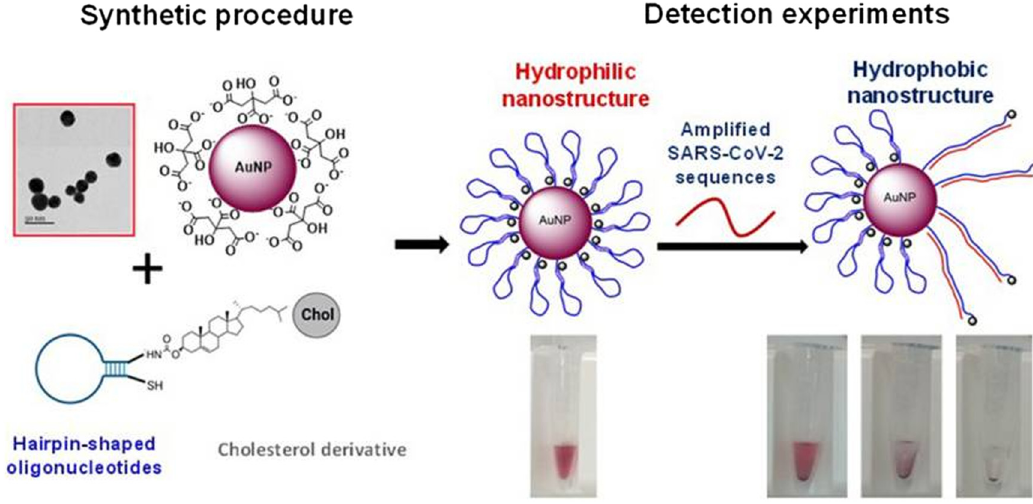
Figure 17: Schematic representation of the sensor [ 108 ]